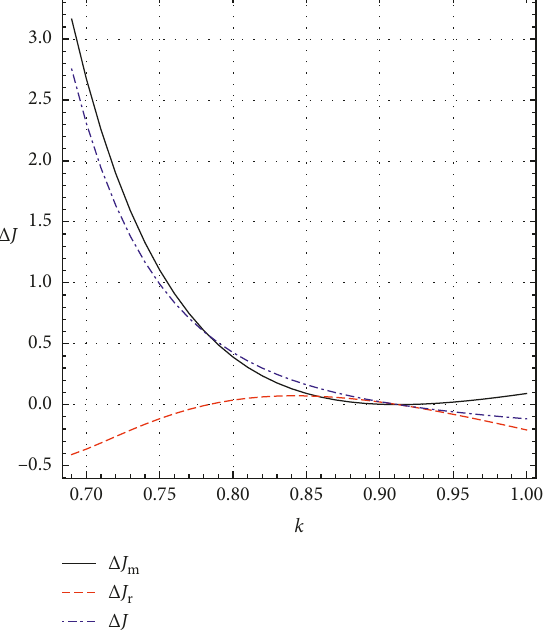
Figure 8: Comparison of steady-state profits with η .